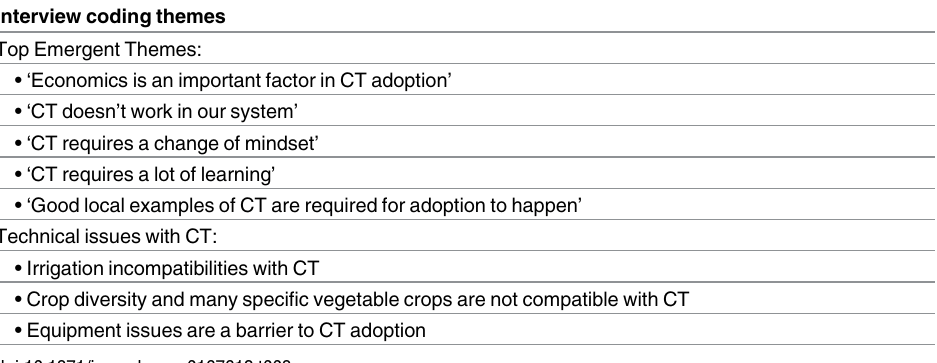
Table 3. Interview emergent themes. The recurring codingthemes listed in the table represent broad senti- ments expressedby interviewed farmers. Quotes and elaborationare reportedin the text. Interview coding